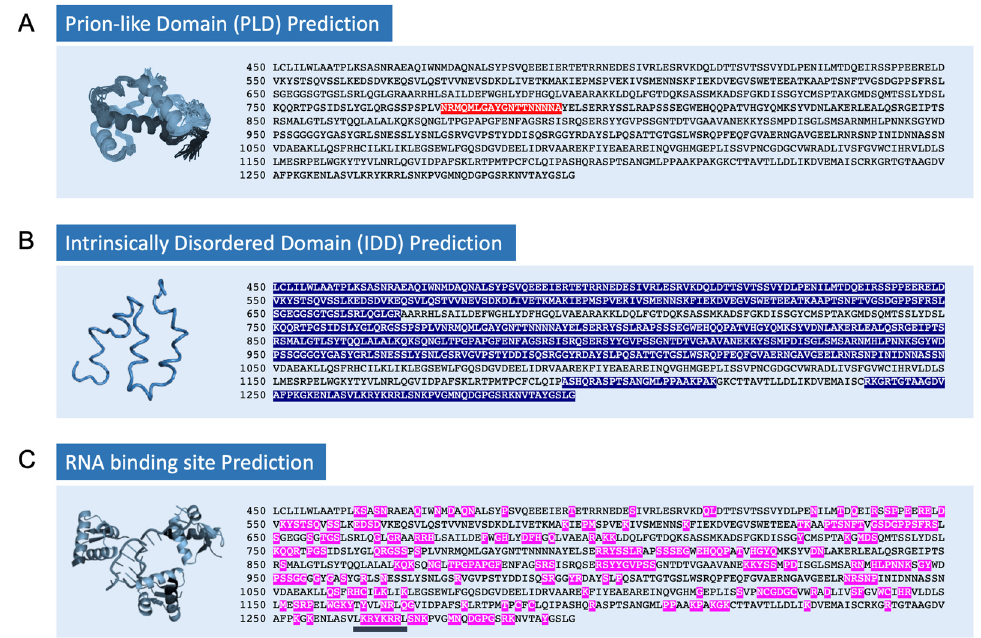
Figure 1. Sequence-based computational studies on the involvement of EIN2 in liquid–liquid phase separation (LLPS). Sequence-based analysis of potential residues and domains in EIN2-C that may be involved in phase separation. ( A ) Prion-like domains predicted by PLAAC (highlighted in red), ( B ) intrinsically disordered domains identified by PrDOS , DEPICTER and IUPred2A web- based server (highlighted in blue), ( C ) putative RNA-binding residues computed by the DRNApred webserver (highlighted in pink). Experimentally validated RNA-binding site in EIN2-C at 1262–1269 is underlined in